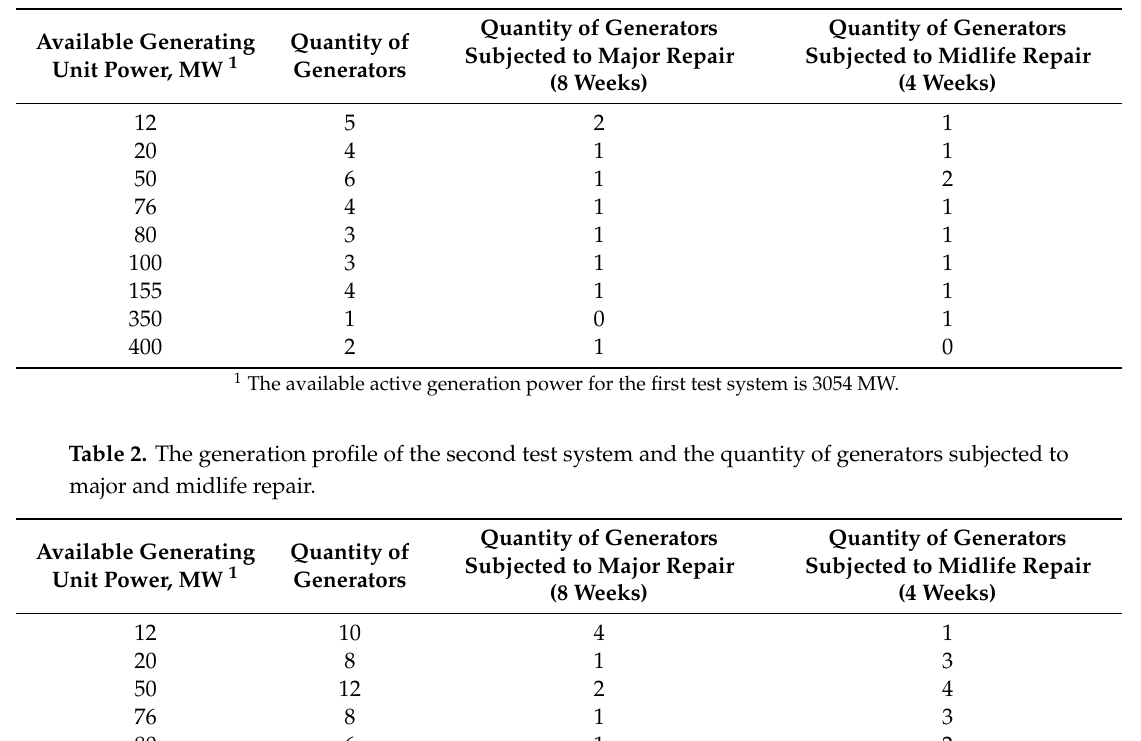
Table 1. The generation profile of the first test system and the quantity of generators subjected to major and midlife repair.